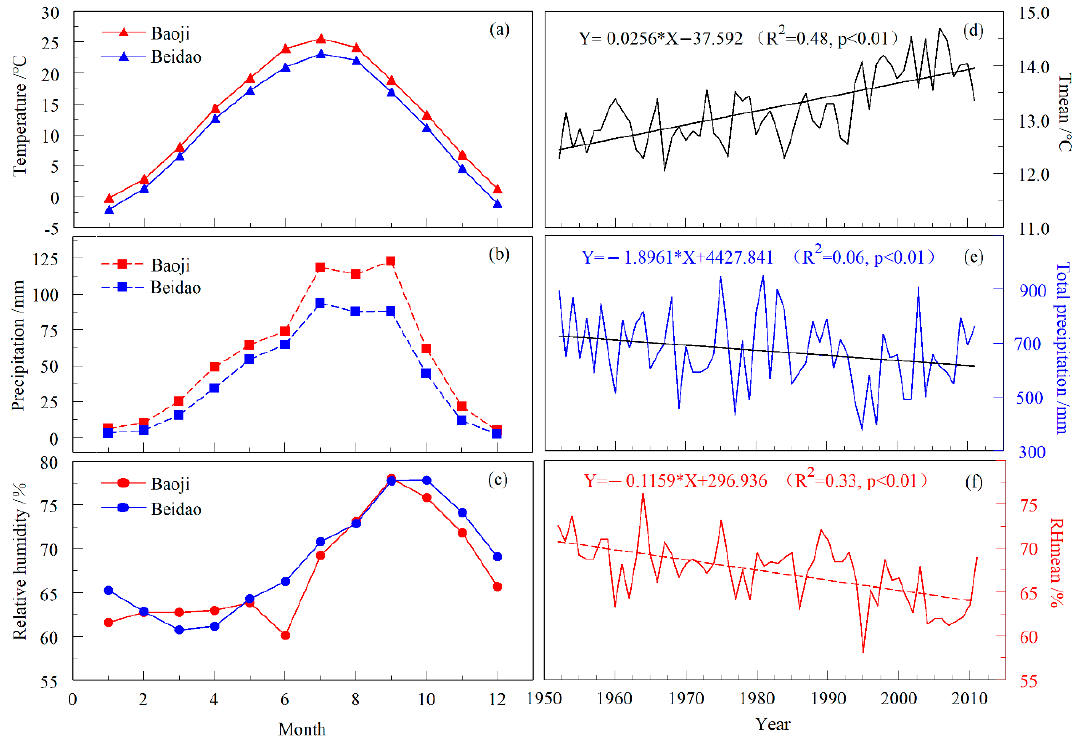
Figure 2. Climatic records of Baoji and Tianshui Beidao Stations. ( a – c ) Multi-year monthly mean temperature, monthly precipitation, and monthly mean relative humidity distributions. ( d – f ) Annual mean temperature, annual total precipitation, and annual mean relative humidity records at Baoji Meteorological Station during 1952–2011, where the oblique line represents the trend of climate change.